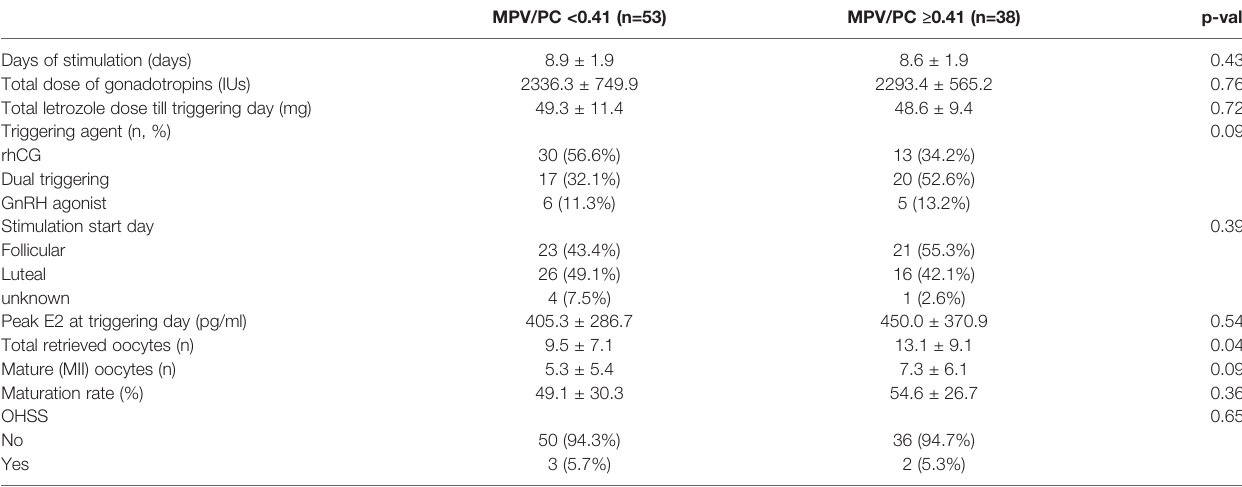
TABLE 5 | Controlled ovarian stimulation outcomes of patients with breast cancer at the MPV/PC cutoff value 0.41 (n=91).